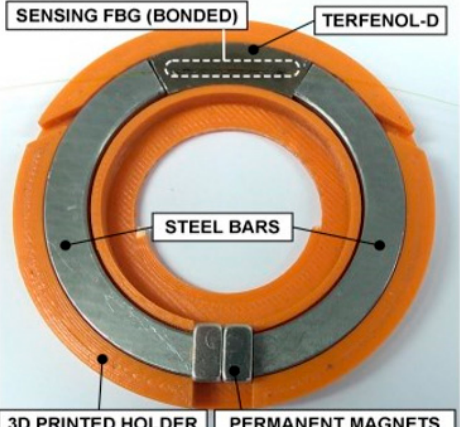
Figure 10. Ring optical fiber current sensor based on 5.6 g magnetostrictive material.